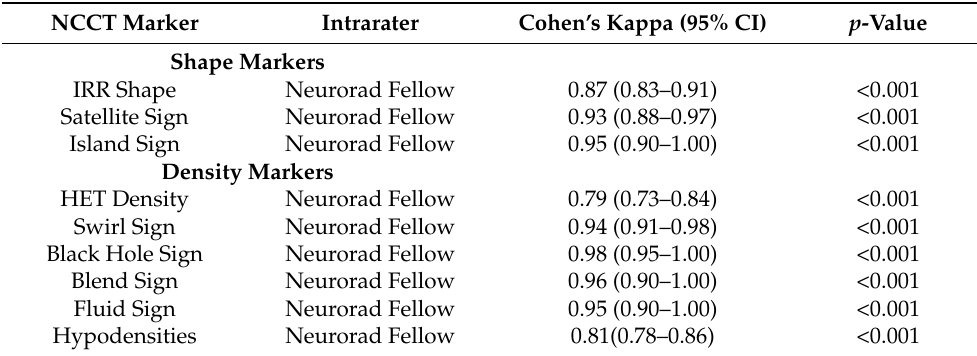
Legend: Intrarater agreement for nine different Noncontrast Computed Tomography (NCCT) markers with stratified Cohen’s kappa across one neuroradiology fellow stratified across two reading. Neurorad Fellow, neuroradiology